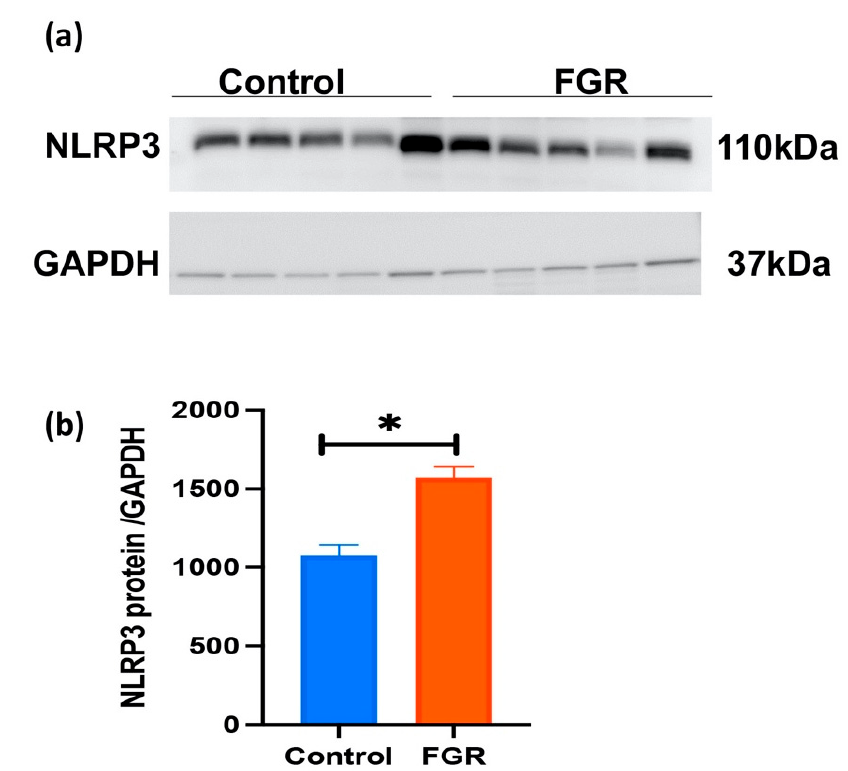
Figure 4. Placental NLRP3 protein expression in control and FGR pregnancies. ( a ) A representative immunoblot shows immunoreactive NLRP3 protein at 110 kDa in placentae obtained from FGR and gestation-matched control pregnancies (n = 5 in each group). GAPDH (37 kDa) was used as a loading control. ( b ). Semi-quantitation of immunoreactive NLRP3 protein normalised to GAPDH demonstrates a significant increase in NLRP3 protein in the placentae from FGR-affected pregnancies compared with gestation-matched control pregnancies. Statistical difference in placental NLRP3 protein content between FGR and control is denoted by * p < 0.05 ( t -test).